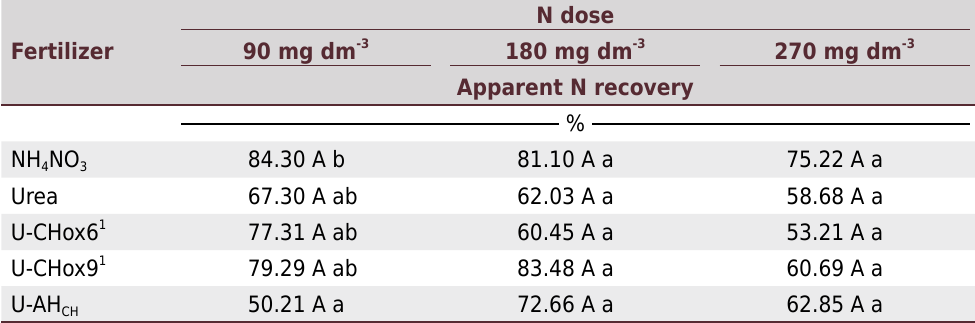
Table 9. Apparent N recovery by corn plants according to the doses of NH 4 NO 3 , urea, and urea mixed with the functionalized charcoals (U-CHox6 or U-CHox9) or humic acids derived from CHox